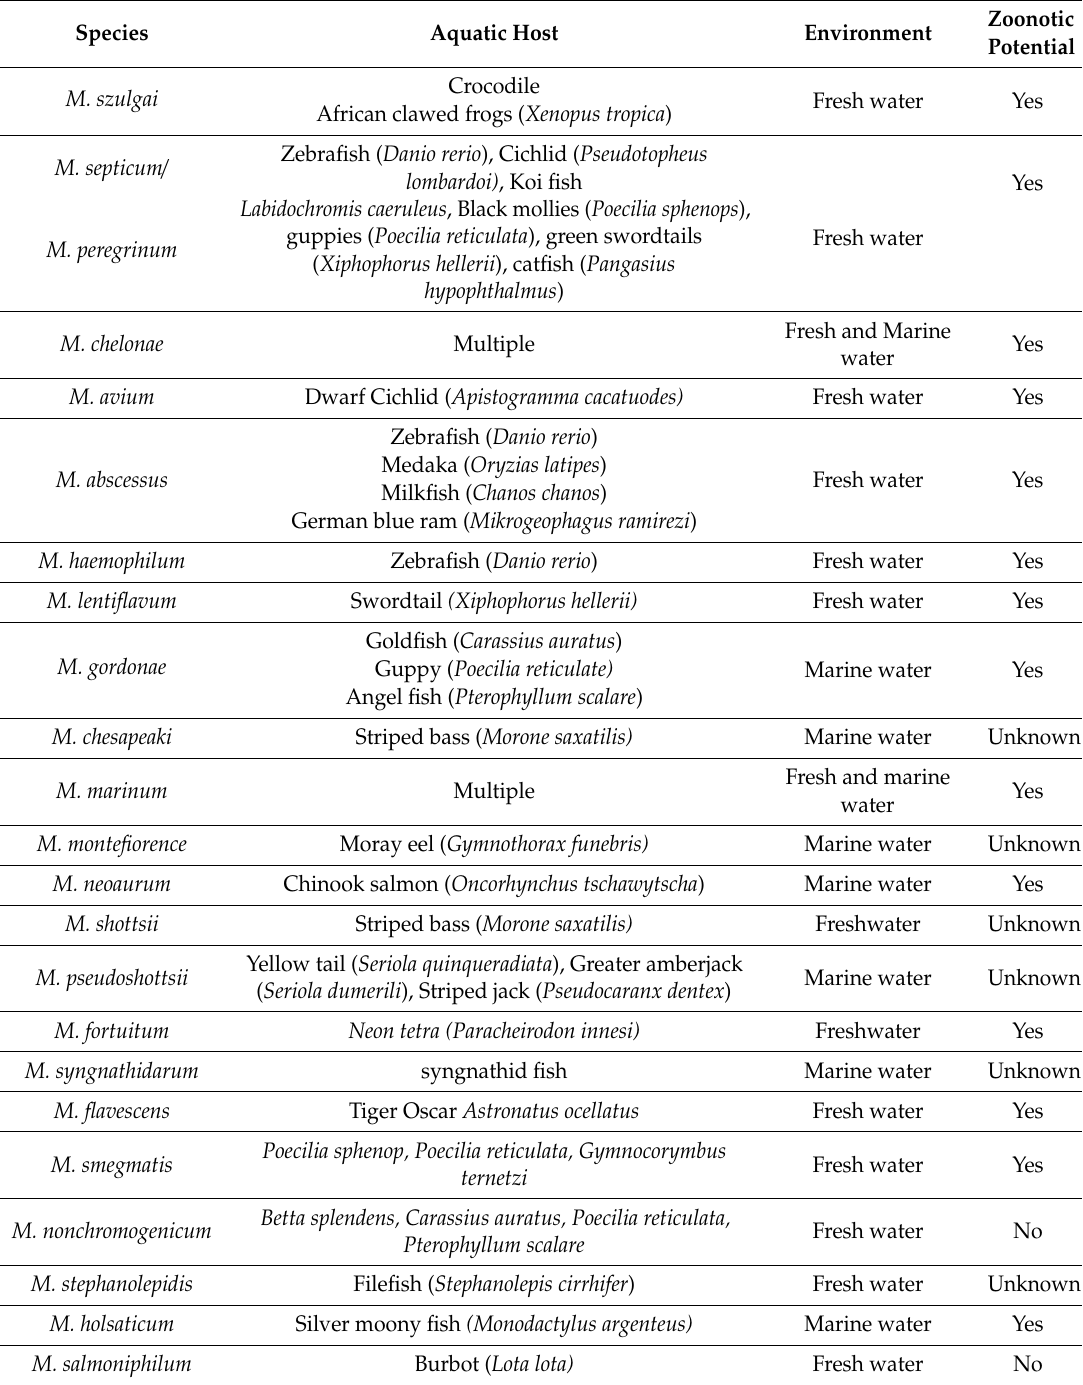
Table 1. Mycobacterium spp., aquatic host and zoonotic